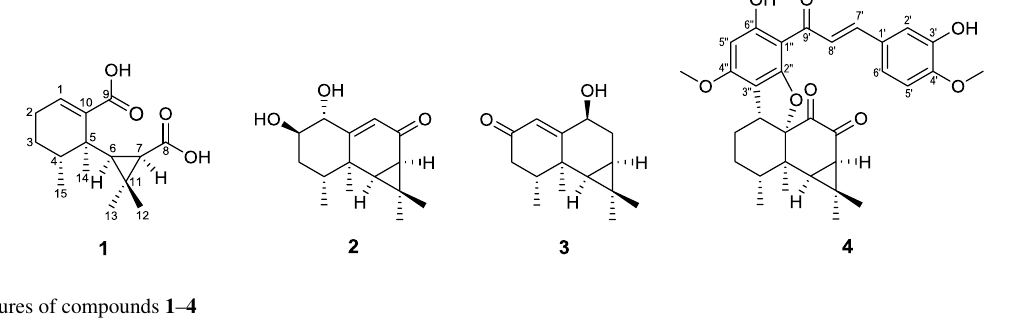
Fig. 1 Structures of compounds 1 –